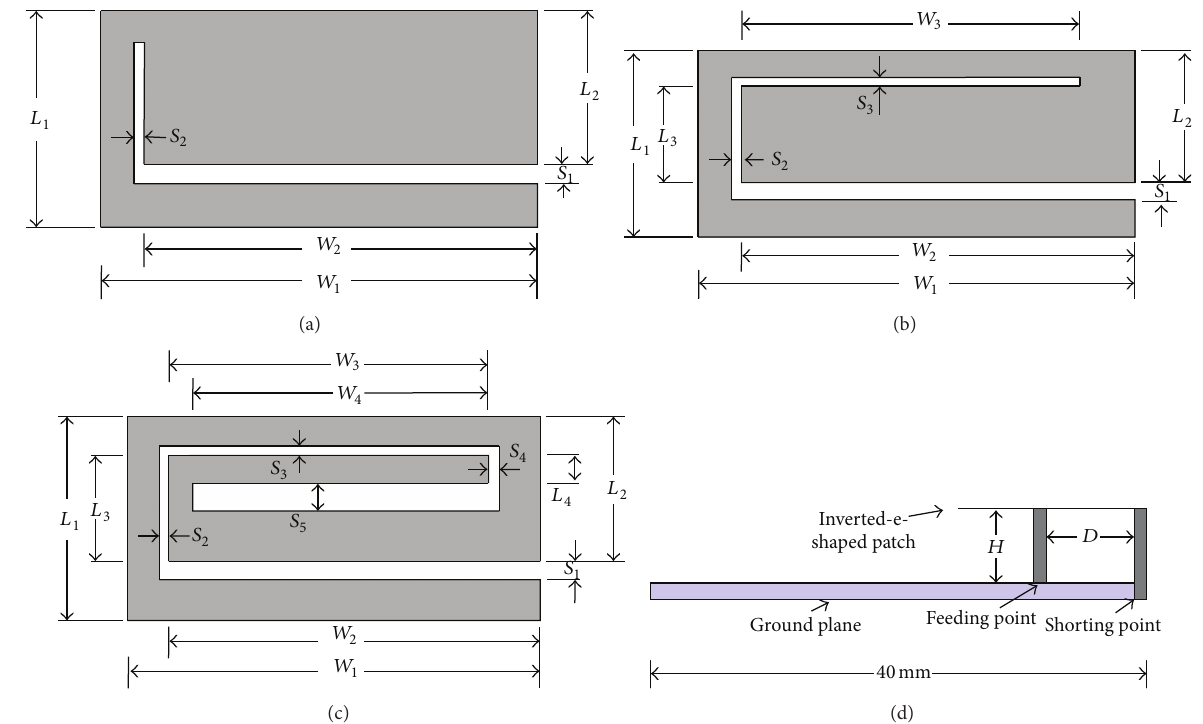
Figure 2: The geometry of designed ((a), (b), and (c)) top view and (b) side view of planar inverted-e antenna.